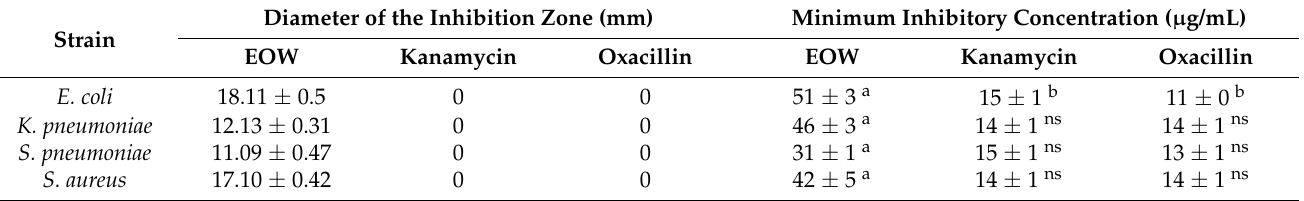
Table 2. Diameters of zones of inhibition and MICs for EOW, Kanamycin, and Oxacillin against strains of bacteria.